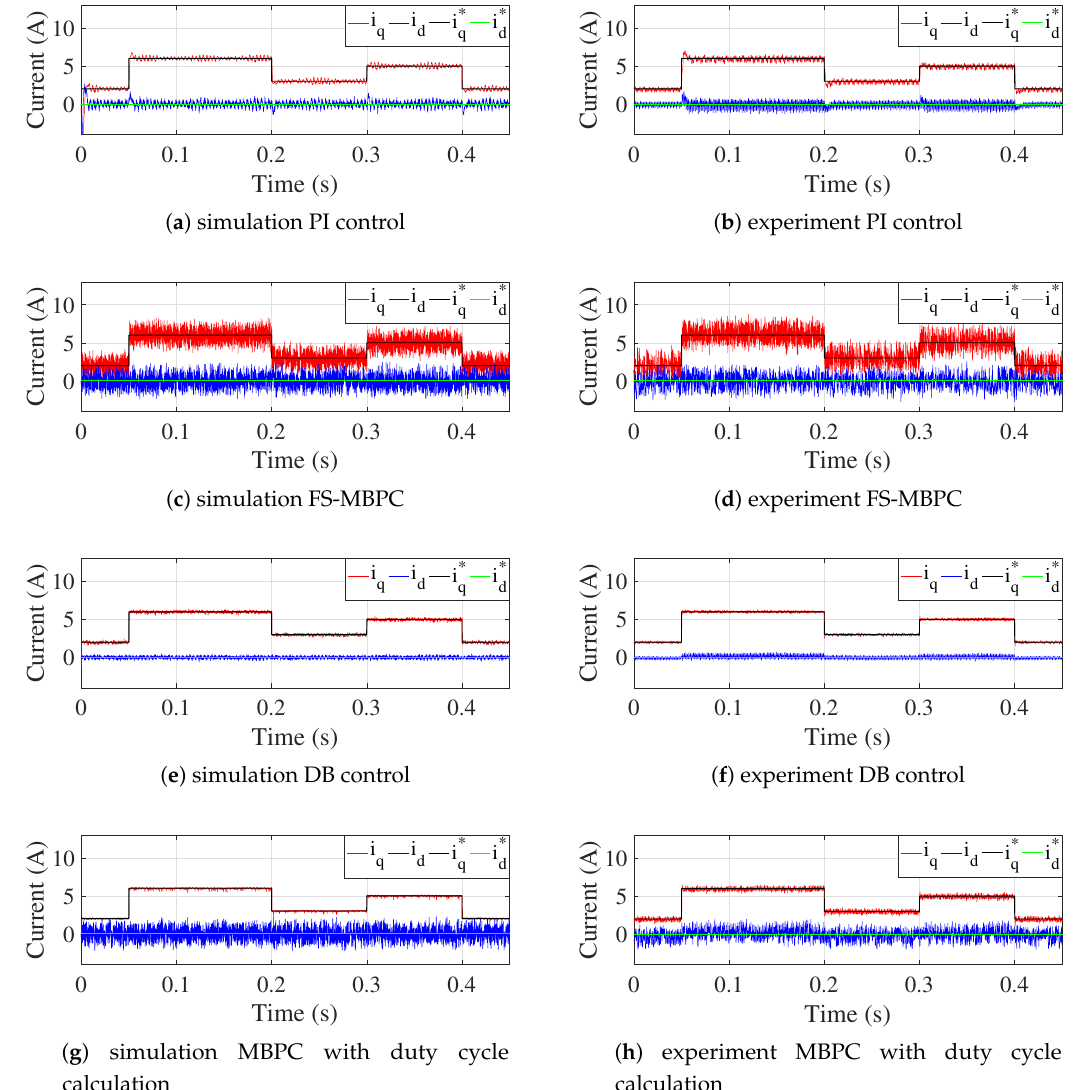
Figure 8. Simulation and experimental results for the stator current components with a healthy rotor ( N = 800 rpm; V dc = 200 V). FS-MBPC: finite-set model based predictive control; DB: deadbeat; MBPC: model based predictive